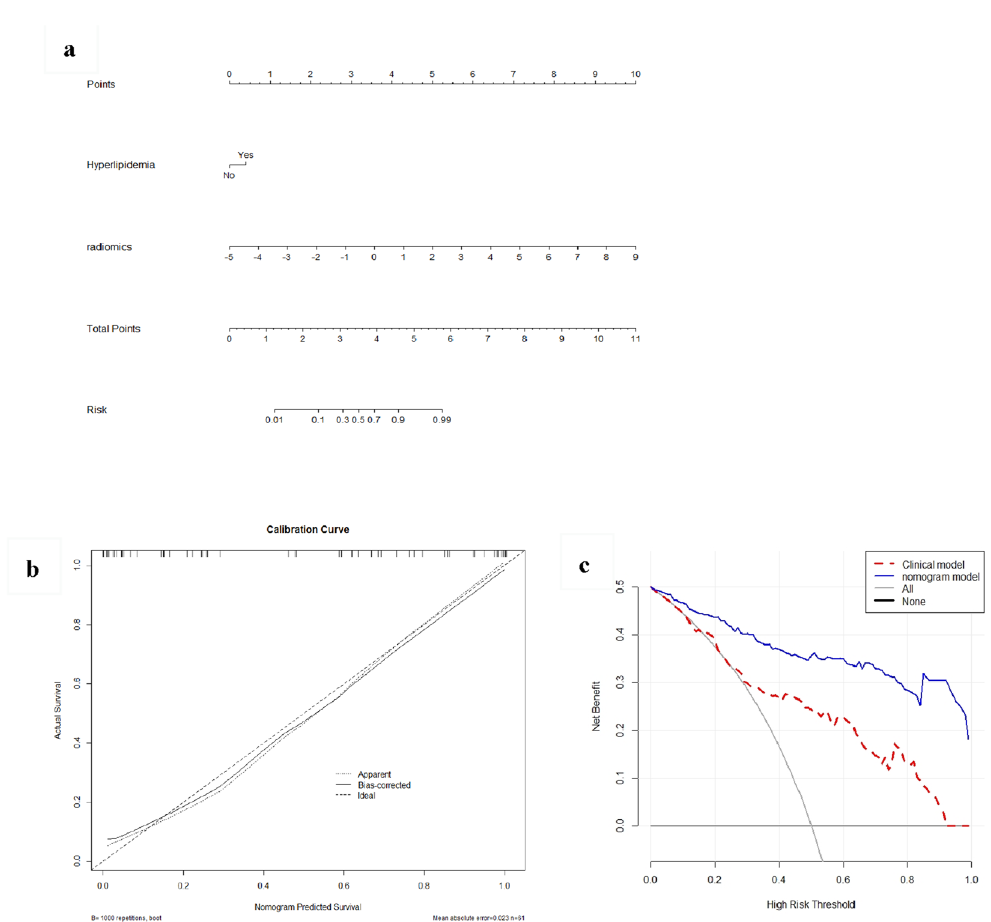
Figure 6. The nomogram model and decision curve analysis for predicting RAP. ( a ) Nomogram model for prediction RAP. ( b ) Calibration curve of the nomogram model. ( c ) Decision curve analysis for nomogram model. The x -axis represents the range of threshold probabilities. The y-axis measures the net benefit, as net benefit = sensitivity × prevalence − (1 − specificity) × (1 − prevalence) × w , where w was the odds in the threshold probabilities. The blue curve represents the nomogram model, and the red curve represents the clinical model. RAP, recurrent acute